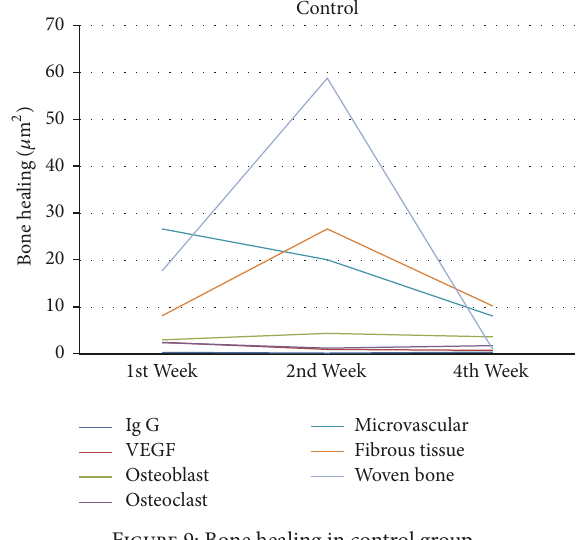
Figure 9: Bone healing in control group.